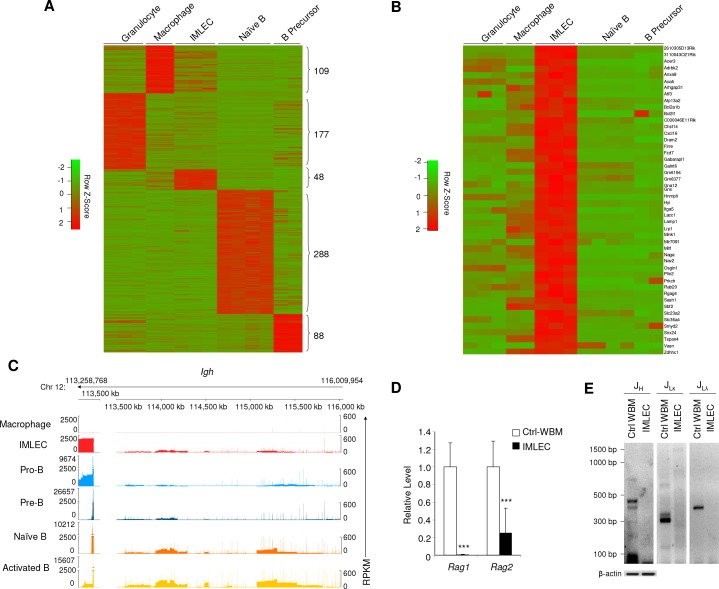
Unique gene signature of Rptor-/- CD11b+ Gr-1- BM IMLECs.(A) Heat map representing the relative expression levels for indicated population-specific genes. Genes up-regulated for at least 4-fold with FDR-adjusted p-value<0.01 were considered population-specific. Numbers on right indicate amounts of population-specific genes. (B) Heat map representing expression levels of 48 CD11b+Gr-1- BM IMLEC-specific genes among indicated populations including macrophage, B precursor, naive B and granulocyte. (C) Genome browser display of transcript structure and gene expression quantity for immunoglobulin heavy chain (IgH) complex gene region from indicated populations. For each track, the normalized numbers of aligned reads count or Reads Per Kilobase of transcript per Million mapped RNA (RPKM) are shown in y-axis, while the gene positions for the sterile transcripts are shown in x-axis. Numbers on top indicate the start and end loci on bases along chromosome 12 for specified gene region. Similar profiles of cKO IMLEC were observed in two other samples analyzed. (D) mRNA levels of Rag1 and Rag2 in cKO CD11b+ Gr-1- BM IMLECs in comparison to Ctrl whole BM cells. n = 6 for Ctrl-WBM; n = 8 for IMLEC. Data are pooled from three independent experiments. (E) IMLECs did not display immunoglobulin gene rearrangement. FACS-sorted CD11b+ Gr-1- cells (IMLECs) from cKO BM were dissected for Ig gene rearrangement patterns of heavy chain (JH), light chains Igk (JLκ) and Igl (JLλ) by PCR. WBM cells from Raptor Ctrl mice were used as positive control. These data have been repeated twice.